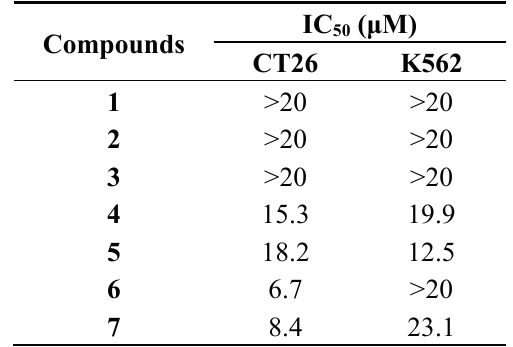
Table 1. IC 50 values of compounds 1 – 7 against colorectal cancer CT26 and leukemia K562